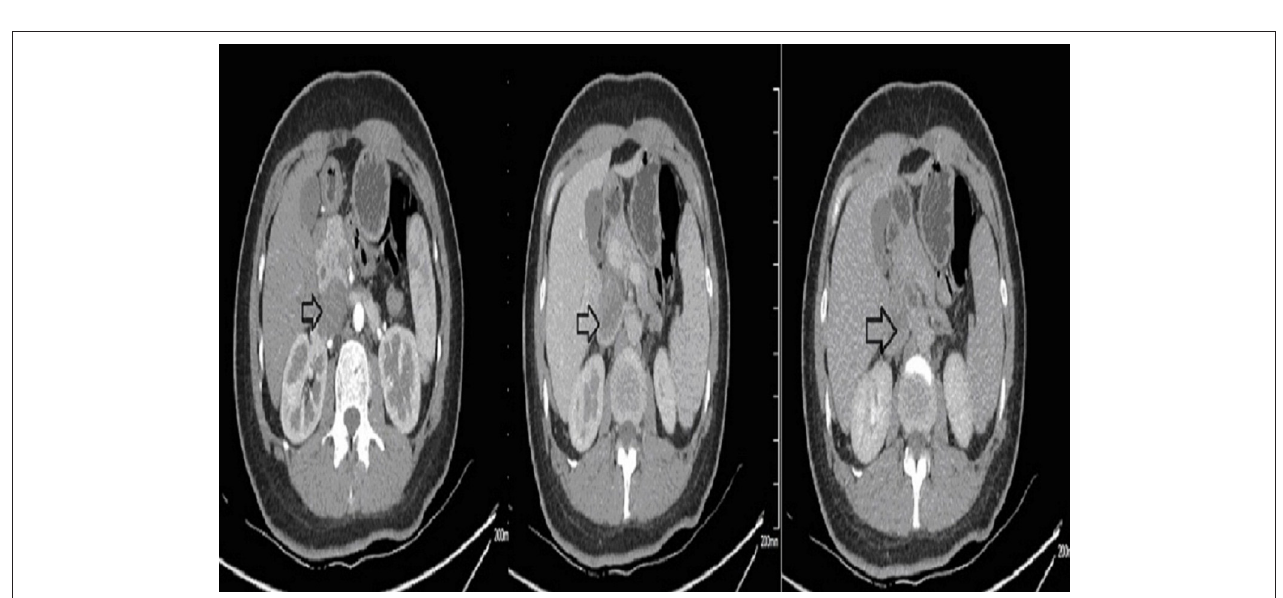
FIGURE 1 | Abdominal ultrasonography images in the epigastric sagittal view: a hypoechoic, irregularly shaped solid mass was seen adjacent to the IVC.